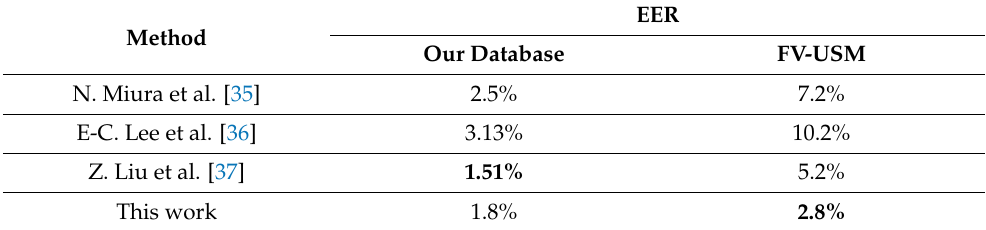
Table 5. Comparison of EER.